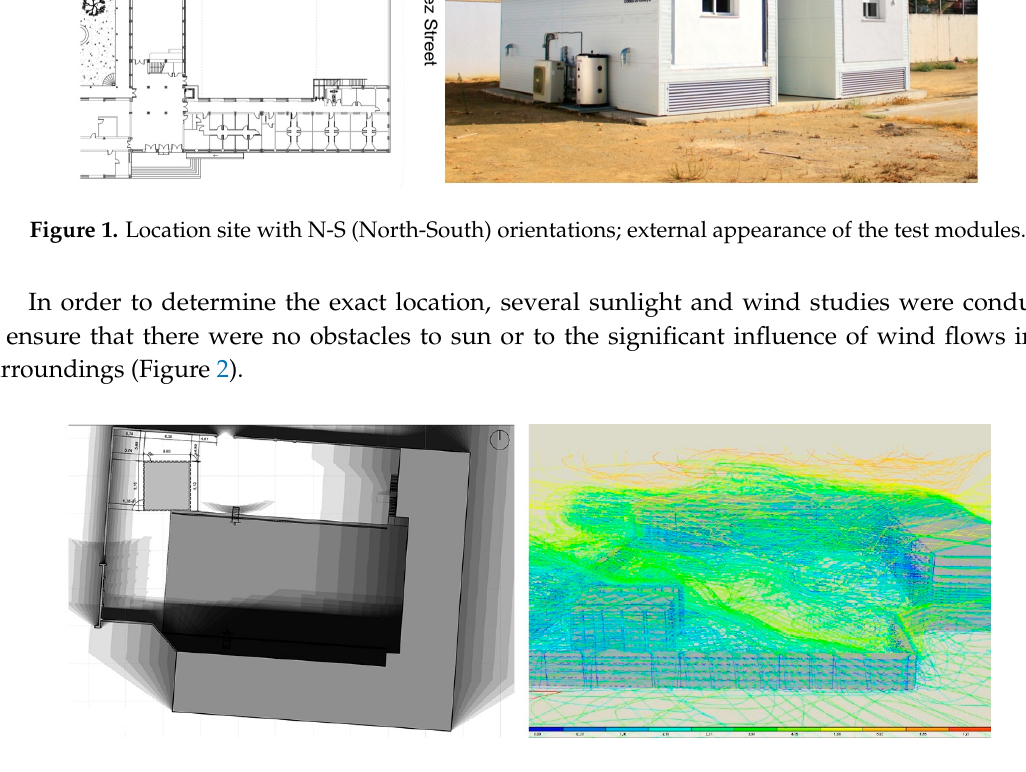
Figure 2. Solar and wind influence study (autumn equinox, 9:00 a.m. to 4:00 p.m.).